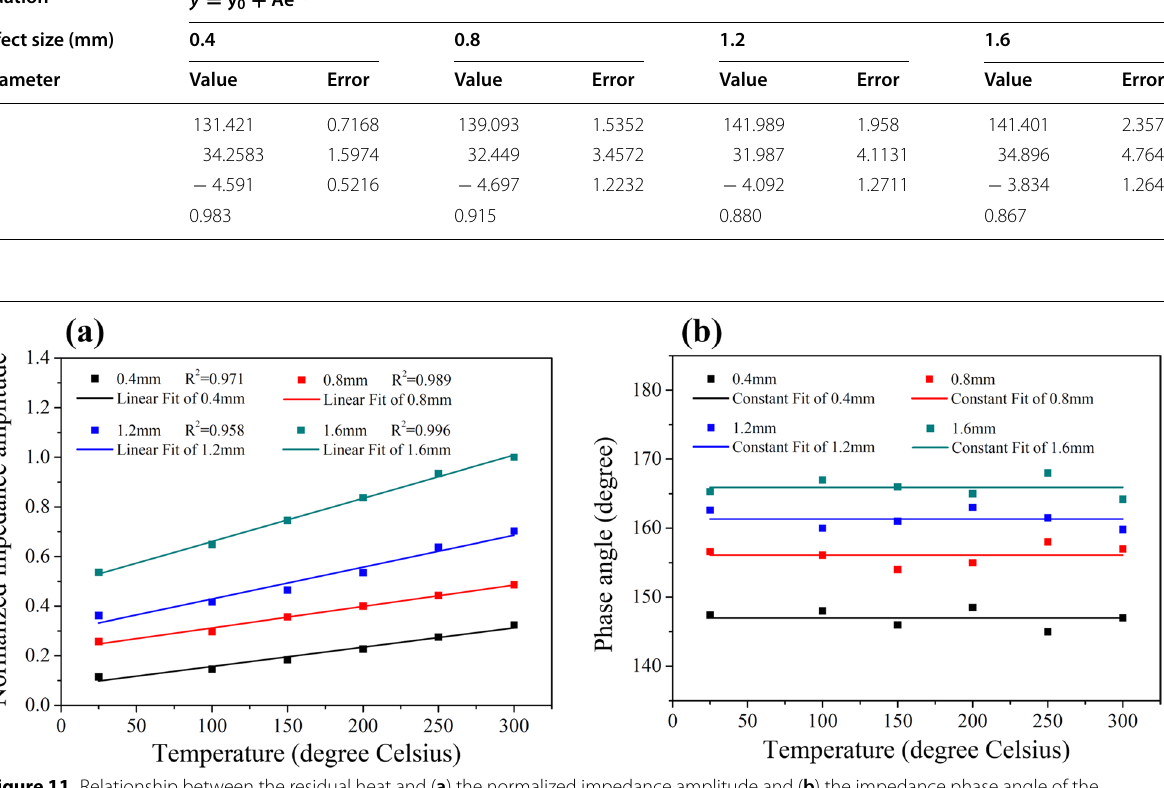
Figure 11 Relationship between the residual heat and ( a ) the normalized impedance amplitude and ( b ) the impedance phase angle of the captured defect EC